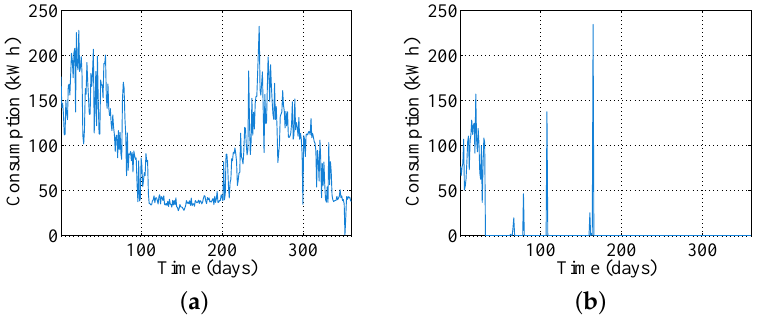
Figure 4. An example of ( a ) a standard and ( b ) a low gas use